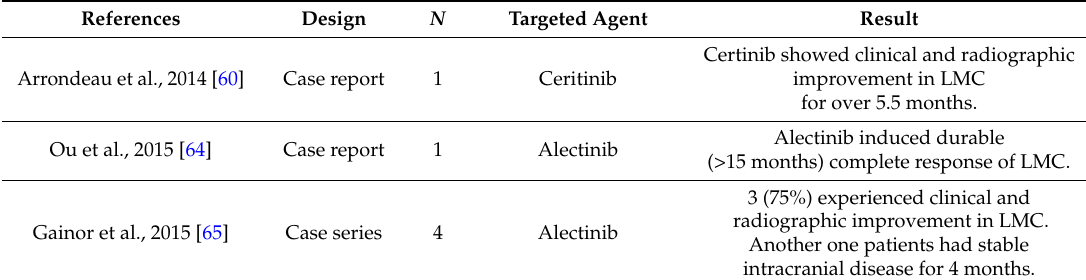
Anaplastic lymphoma kinase ( ALK ) inhibitor in ALK (+) NSCLC with leptomeningeal